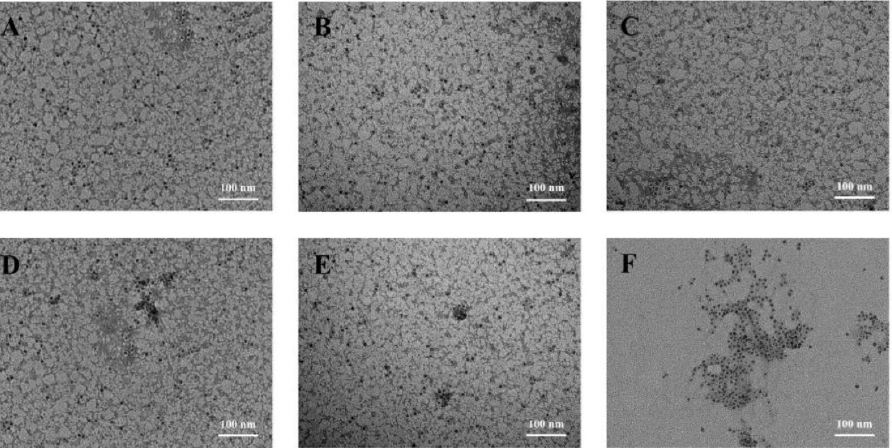
Figure 6. TEM images of NPLF at different thermal treatment temperatures. Figures ( A – F ) are control (untreated ferritin) and thermal treatment on 60, 70, 80, 90, and 100 °C, respectively.